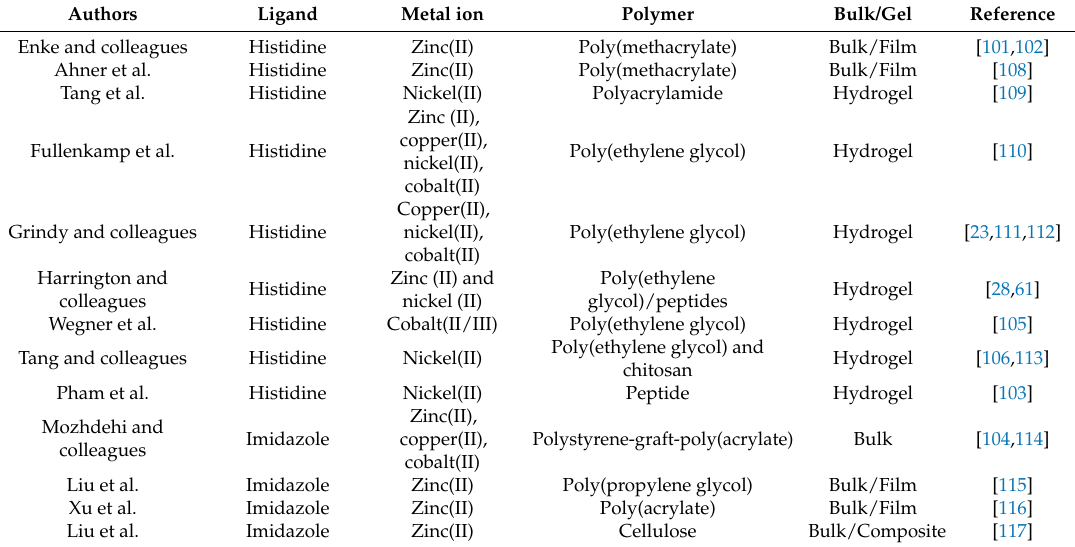
Table 2. Summary of the different utilized design strategies for the fabrication of histidine-containing synthetic